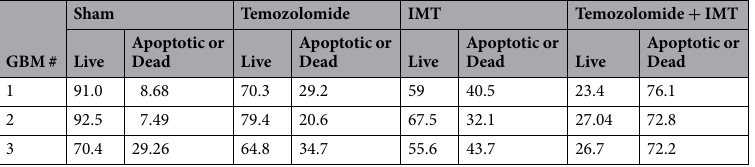
Table 2. Individual flow cytometry measures of IMT response in patient GBM cells. Shown are the percentages (%) of live (Annexin − /PI − ) versus apoptotic (Annexin + /PI − ) or dead (Annexin + /PI + ) patient GBM cells quantified with flow cytometry. Each condition was evaluated in 3 biological replicates with 15,000–30,000 patient GBM cells exposed to the indicated treatment for 3 days. The differences in therapeutic impact between groups were highly significant and are summarized in Fig.